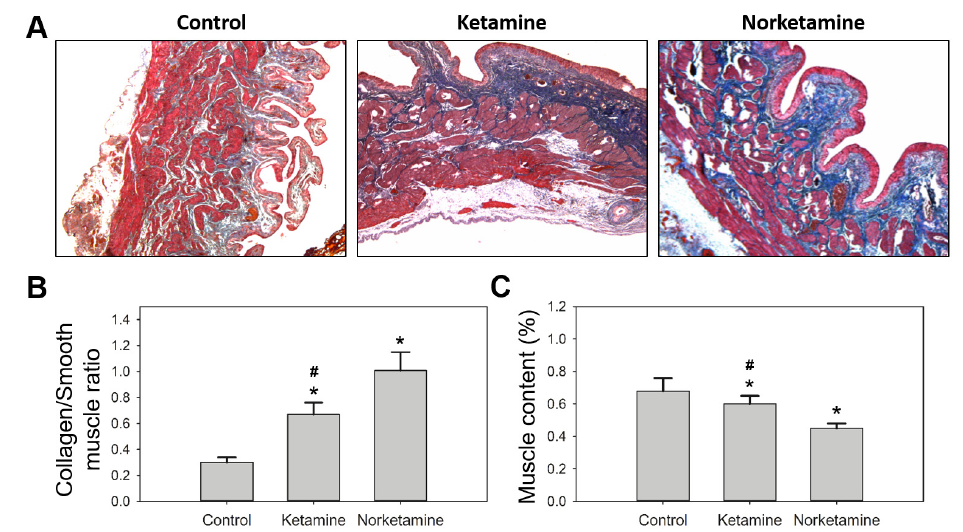
Figure 4. Masson’s trichrome staining of the bladder of the rats in each group ( A ), and the statistical analysis of collagen/smooth muscle ( B ) and smooth muscle content (%) of each group ( C ). * indicates statistical differences in comparison with the control group, p < 0.05; # indicates statistical differences in comparison with the norketamine group, p < 0.05.